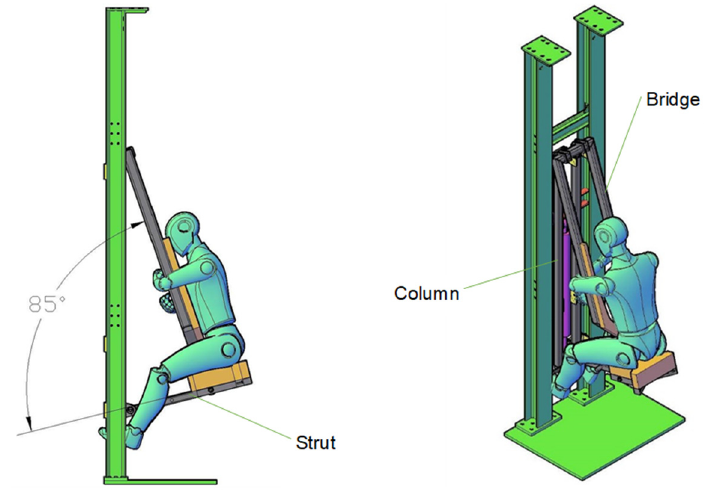
Figure 1. Chair structure and body posture.